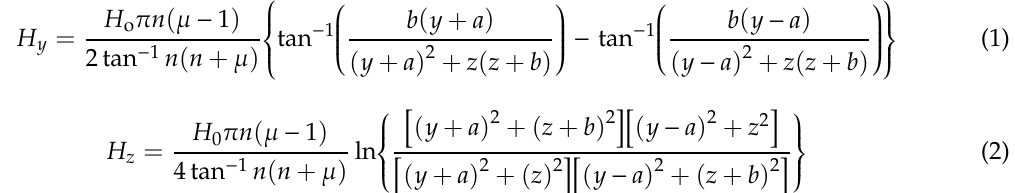
Figure 1. Schematic of a rectangular defect with magnetic charge density ± S m .